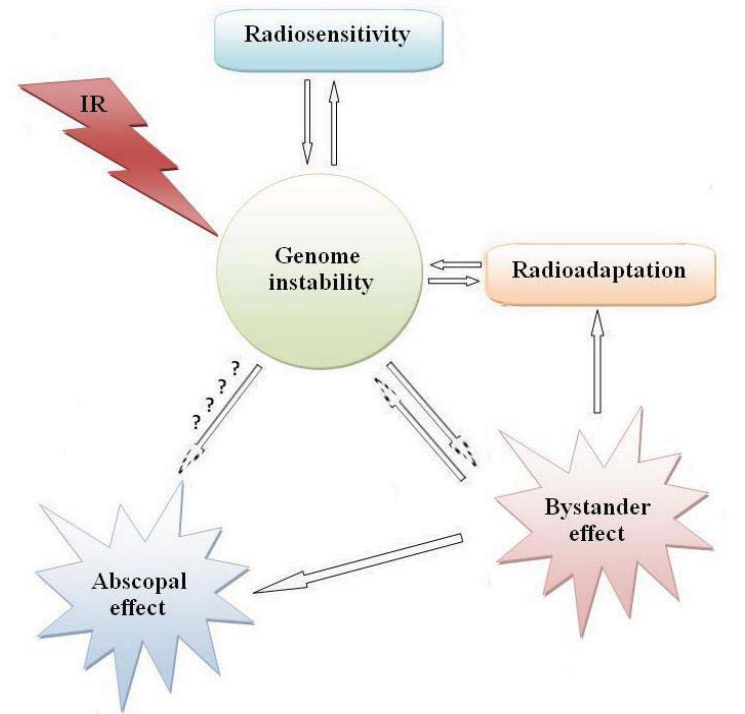
Figure 1. Possible inter-relationships between cellular responses to ionizing